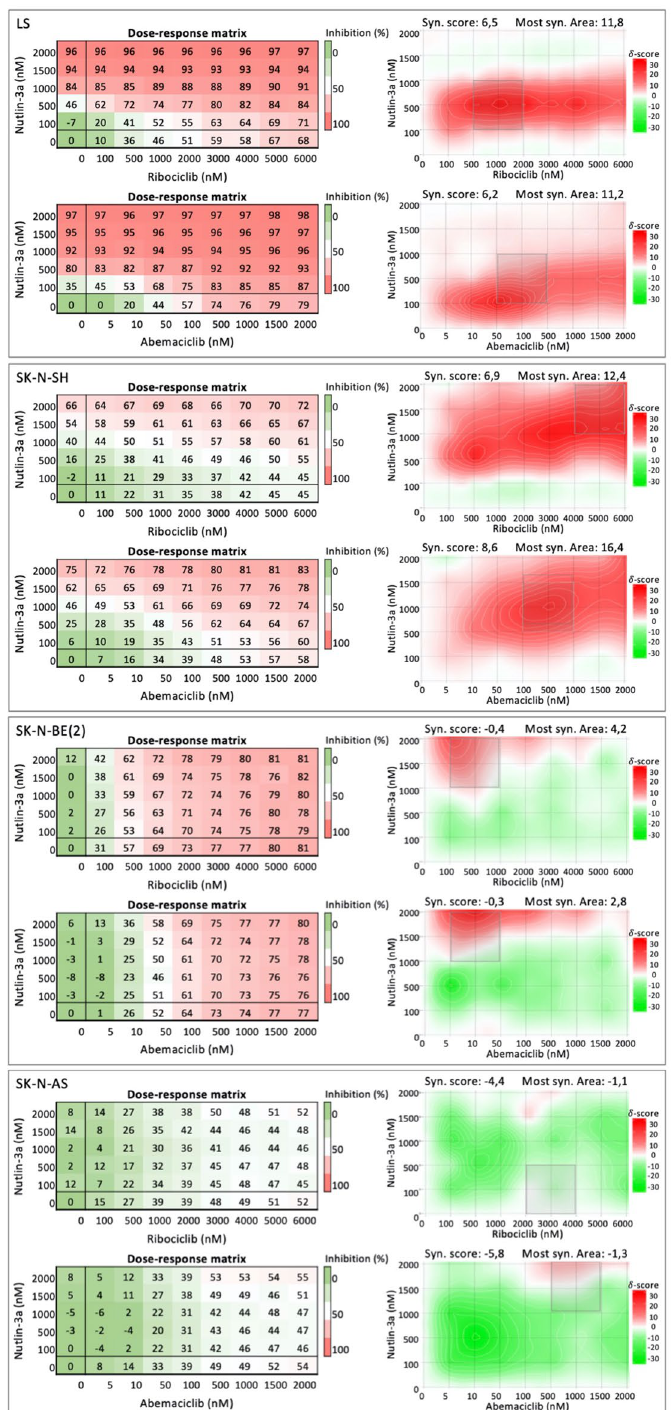
Figure 5. Inhibition dose–response matrix and synergy score heatmaps for representative neuroblastoma cell lines. Dose–response matrix and synergy score heatmaps generated by SynergyFinder for combinational treatment with Nutlin-3a and ribociclib and with Nutlin-3a and abemaciclib for the cell lines LS ( CDK4/MDM2 - amp, p53 wt , MNA), SK-N-SH (p53 wt , MNA), SK-N-BE (p53 mut , MNA), and SK-N-AS (p53 mut ). Dose–response matrix and synergy score heatmaps for all used cell lines can be found in Supplementary Fig.